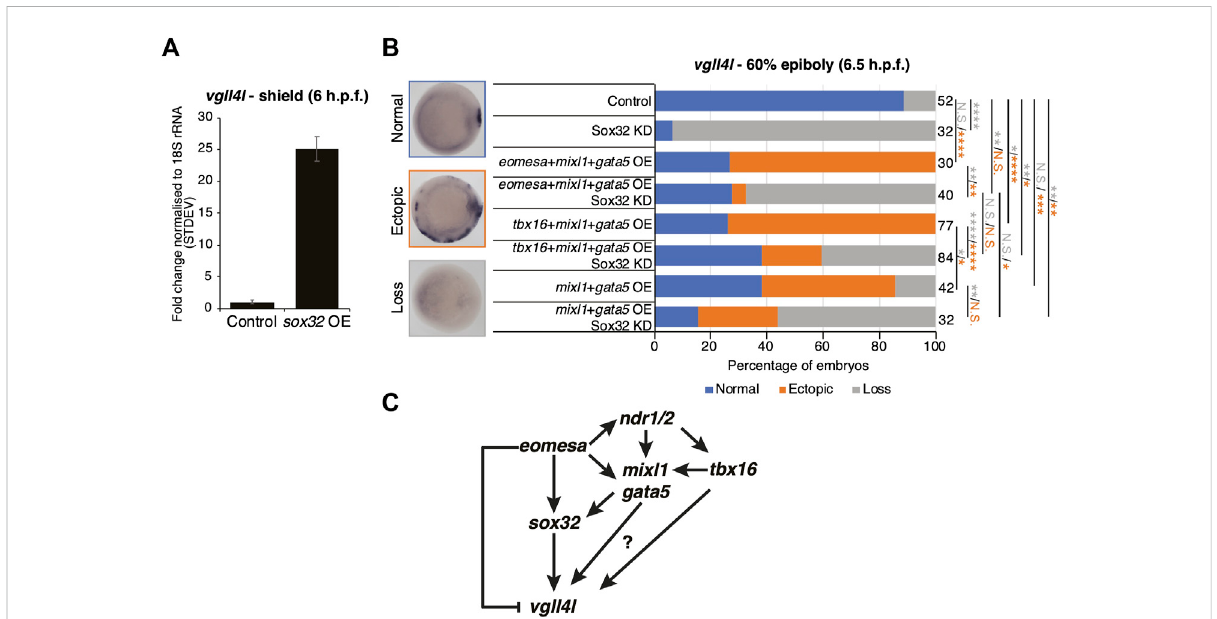
FIGURE 6 Eomesa activation of vgll4l isthroughfeedforward loopsvia sox32 anditsupstreamactivators. (A) qRT-PCR analysis of vgll4l expression inearly gastrulas (6 h.p.f.) in control embryos and those injected with sox32 mRNA at the 1 cell stage. Expression is represented as fold change relative to control normalised to 18S rRNA. (B) WISH analysis of the ability of vgll4l expression in early gastrulas (6 h.p.f.) in embryos injected with mRNAs at the one-cell stage as indicated, with and without Sox32 morpholino knockdown. N = 2. Total numbers of embryos scored per condition are indicated.Representative images ofexpressionpatterns pergene percategoryare shown. Animalviews; dorsalto theright. Fisher ’ sExacttwo-tailed